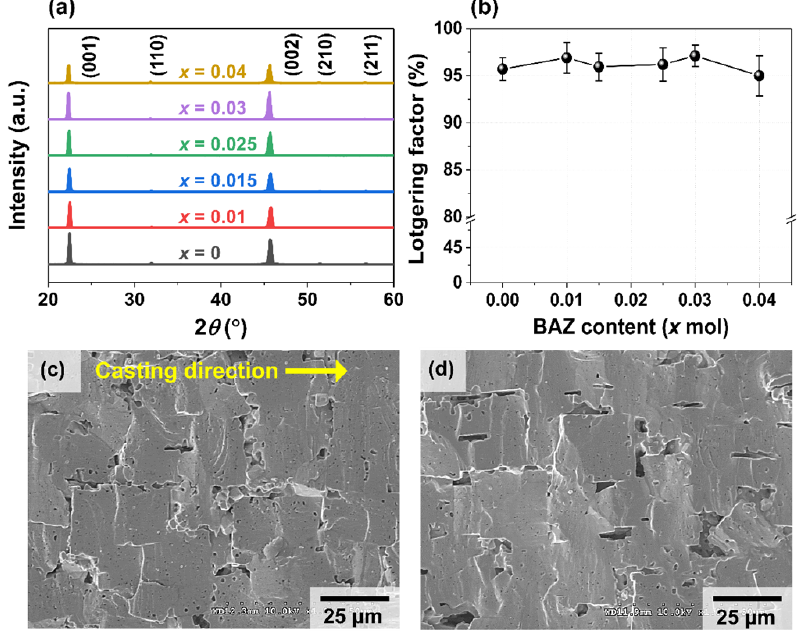
Figure 5. ( a ) XRD patterns and ( b ) Lotgering factors of the textured NKNS-(0.04 − x)SZ-xBAZ thick films (0.0 ≤ x ≤ 0.04). SEM images of the textured NKNS-(0.04 − x)SZ-xBAZ thick films with ( c ) x = 0.015 and ( d ) x = 0.03.